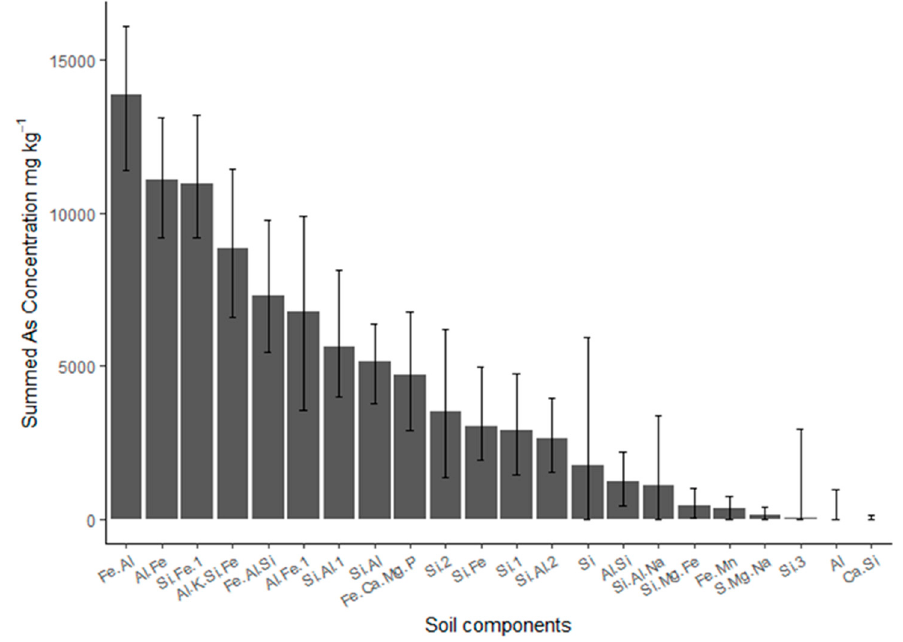
Figure 8. Solid phase distribution of total As between the soil intrinsic soil constituents (ISCs) in south-west England.